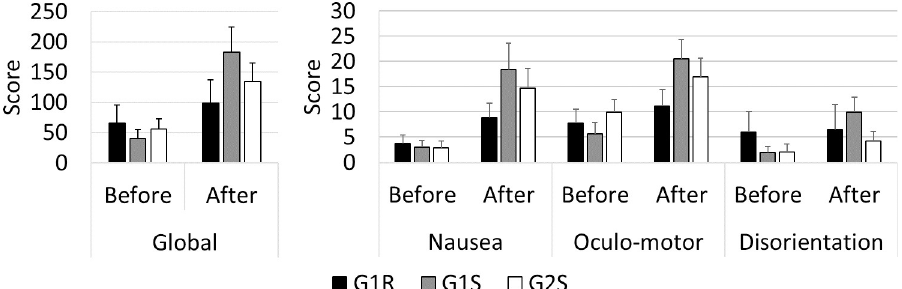
Fig 5. The SSQ scores. On the left, the global score; on the right, the details of the subscale scores.